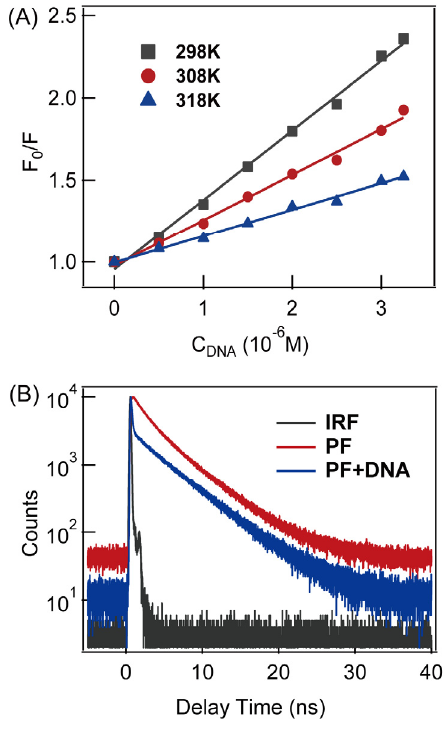
Figure 2. ( A ) Fluorescence quenching experiments of proflavine (5 µ M) at indicated temperatures in buffer solution (pH = 7.4); the fluorescence quenching constant ( K SV ) was determined to be (4.2 ± 0.1) × 10 5 M − 1 , (2.8 ± 0.1) × 10 5 M − 1 and (1.6 ± 0.1) × 10 5 M − 1 at 298 K, 308 K and 318 K, respectively; ( B ) fluorescence kinetics of proflavine (15 µ M) and PF-DNA (15 µ M PF with 20 µ M DNA) in buffer solution (pH = 7.4); IRF is the instrument-response function of TCSPC